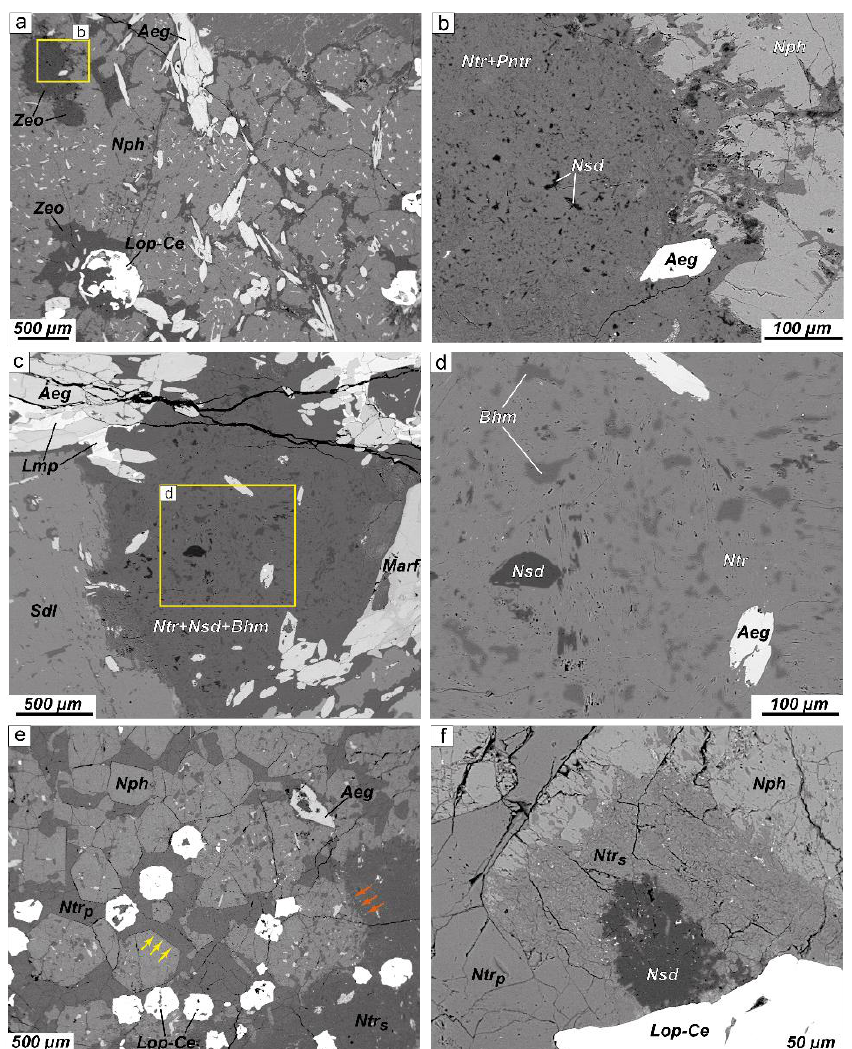
Figure 5. Secondary alteration of nepheline and sodalite in urtite from the Layered complex. ( a ) Alteration of nepheline by an aggregate of natrolite + paranatrolite + nordstrandite (Zeo); BSE-image; ( b ) detailed BSE-image of the Figure 5a; ( c ) alteration of sodalite by an aggregate of natrolite + nordstrandite + böhmite; BSE image; ( d ) detailed BSE image of Figure 5c; ( e ) primary natrolite filling the intergranular space of nepheline grains (left side of the figure) and secondary aggregates natrolite + paranatrolite + nordstrandite replacing nepheline (right side of the figure). The yellow arrows indicate the primary natrolite/nepheline boundary (no alteration), the orange arrows indicate the secondary natrolite/nepheline boundary; BSE image; ( f ) relationship between primary and secondary natrolite; BSE image. Ntr p — primary natrolite; Ntr s — secondary natrolite; Zeo — natrolite + paranatrolite + nordstrandite. Samples LV-319G ( a,b ), LV-335/6 ( c,d ), and LV-363/17 ( e,f ).